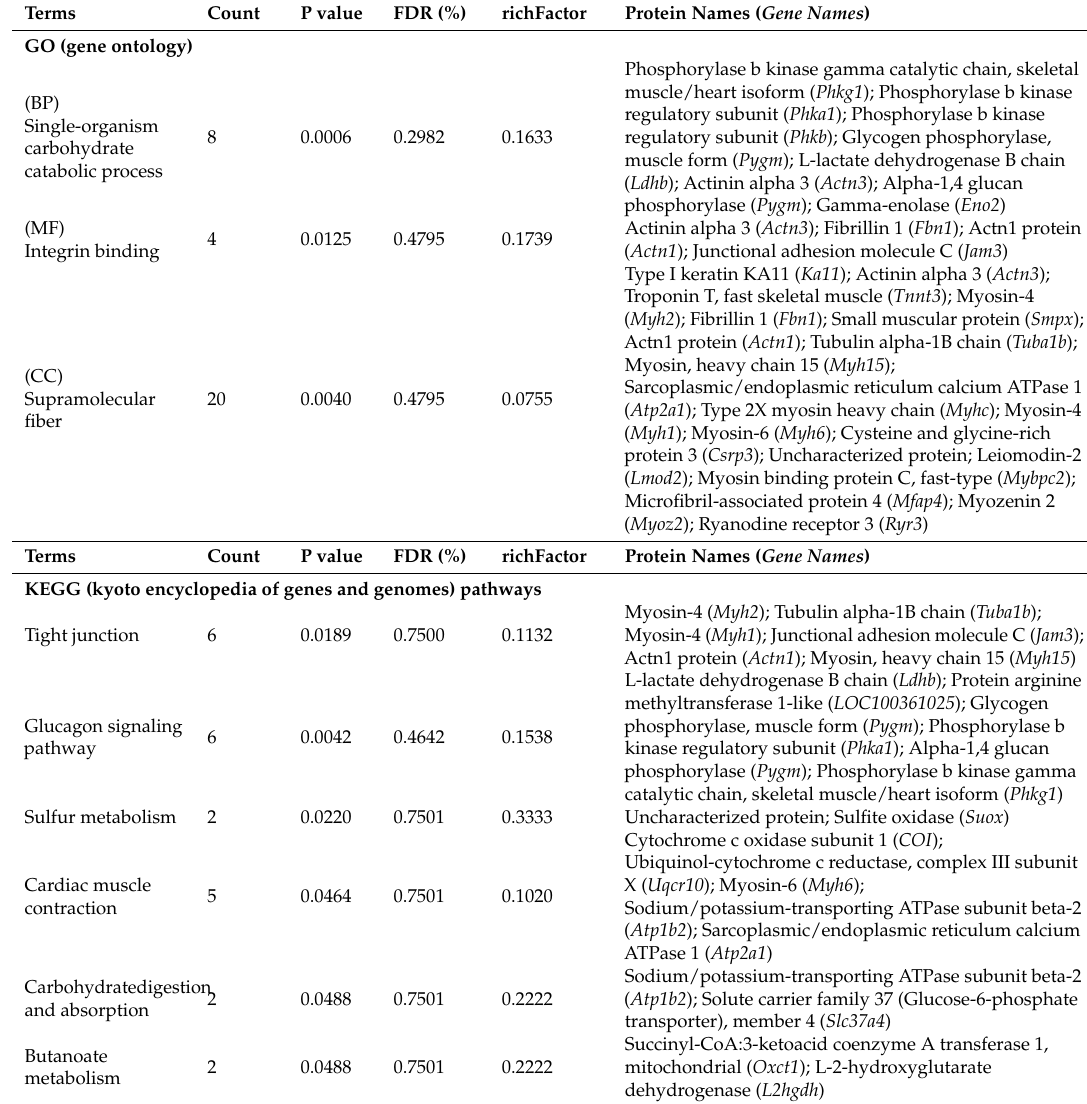
Table 1. Distribution of proteins and signaling pathways response to dry needling combined with static stretching treatment based on GO and KEGG